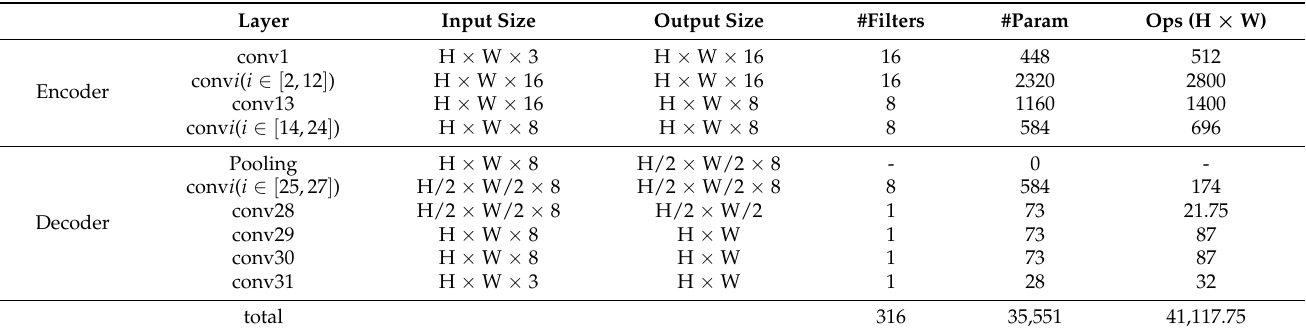
Table 2. Configurations of the LightEyes (H and W below represent the height and width of the input